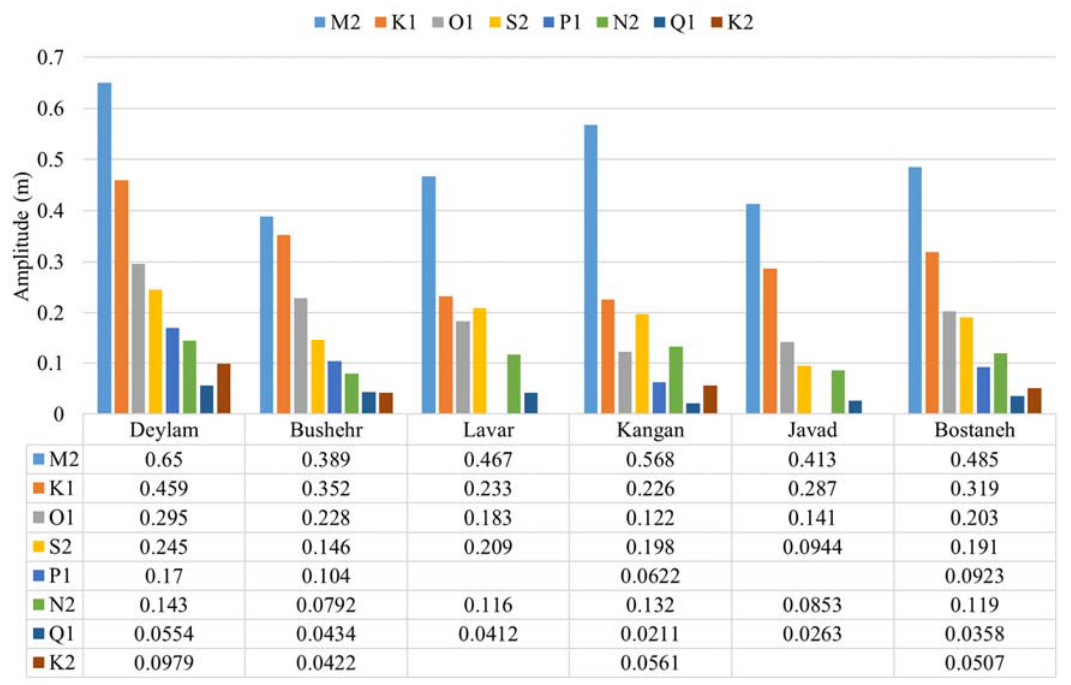
Figure 7. Amplitude of the main tidal constituents in all stations.